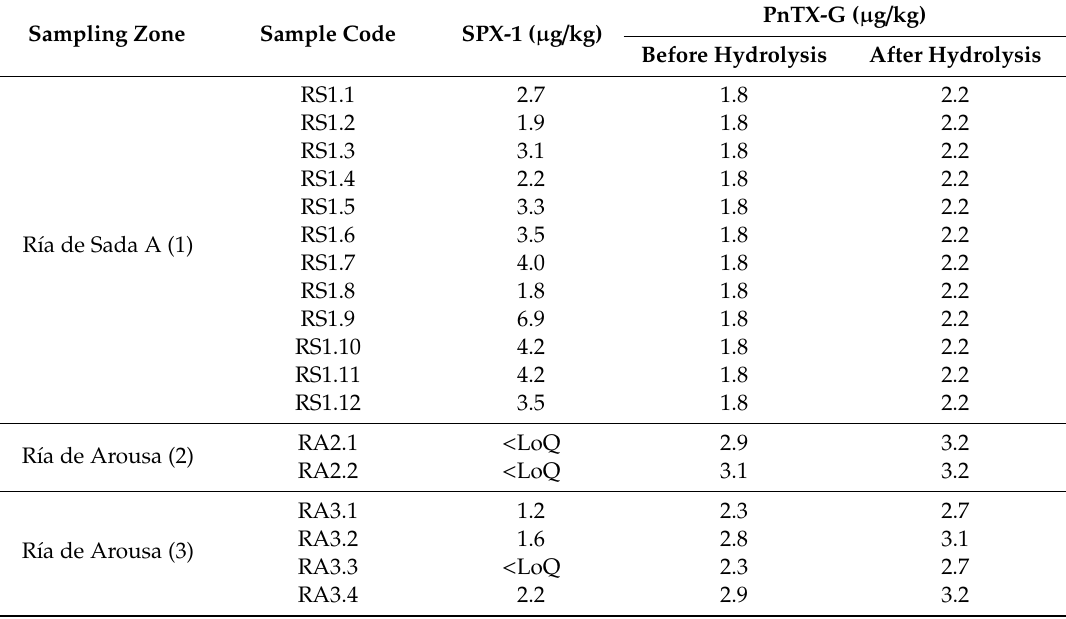
Table 3. Concentration of CIs ( µ g / kg) obtained in the LC-MS / MS analysis of samples following European Union Reference Laboratory for Marine Biotoxins (EURLMB) standard operating procedure. LoQ: limit of